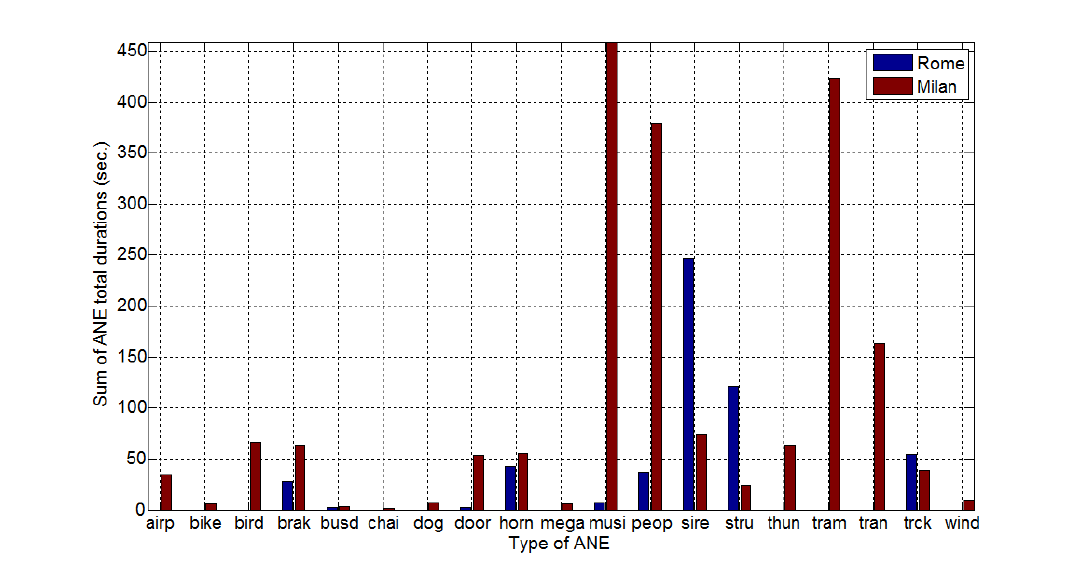
Figure 8. Histograms showing the accumulated ANE durations per category differentiating both locations Rome (suburban) and Milan (urban). The x -axis show the ANE category.